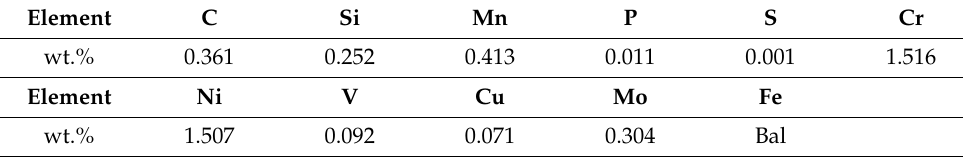
Table 1. Chemical composition of the alloy